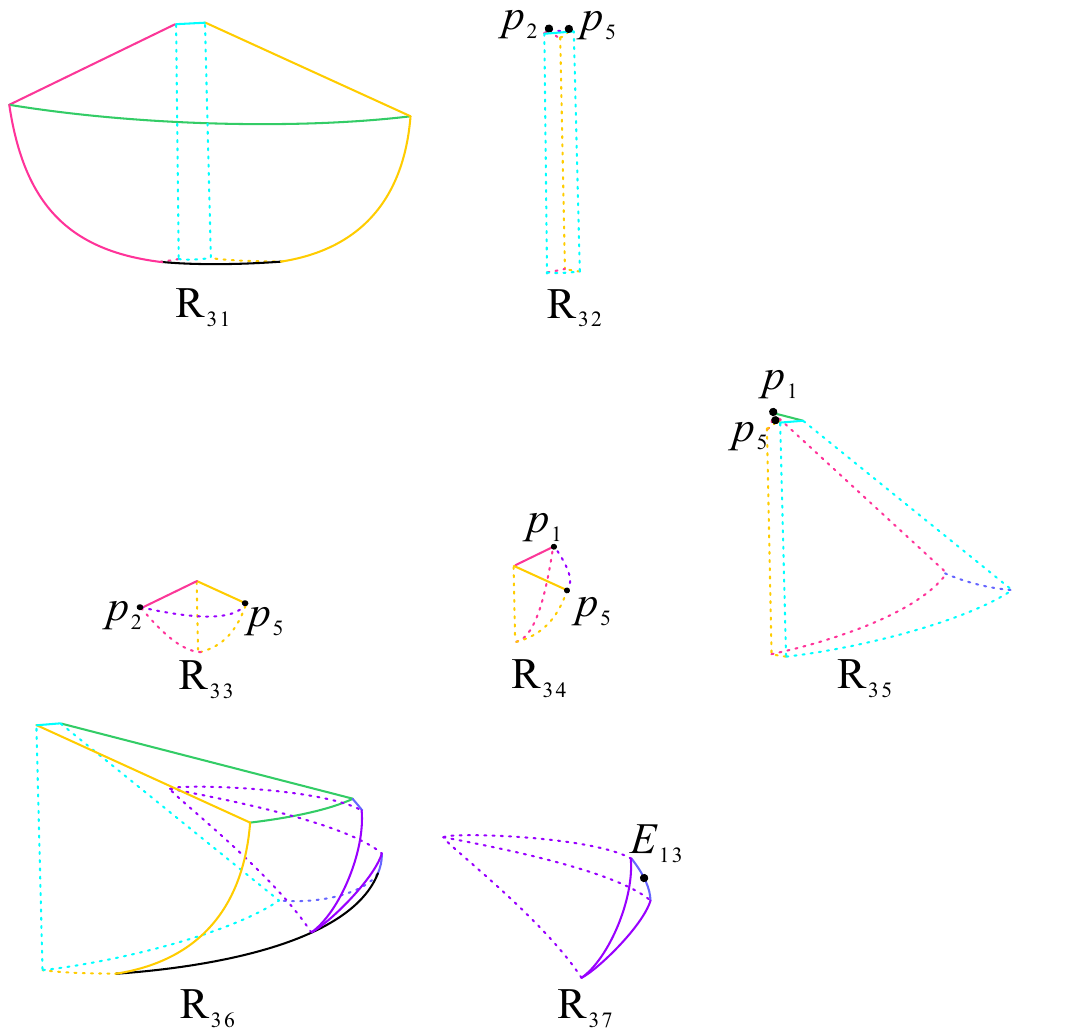
Figure 7. The region R 3 is divided into seven subregions by the five planes y = 0, z = 0, Ω ( m ) = 0, b 2 = 0, and b 3 = 0, and one surface b 1 =